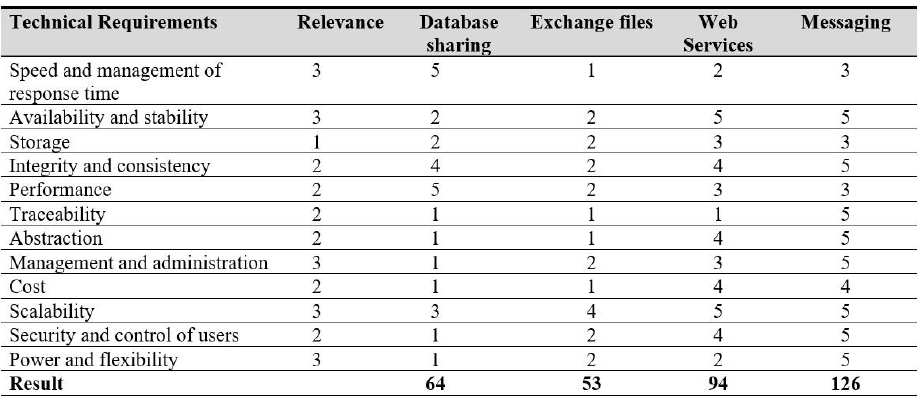
Figure 7. Assessment of exchange mechanisms to carry out integration processes.